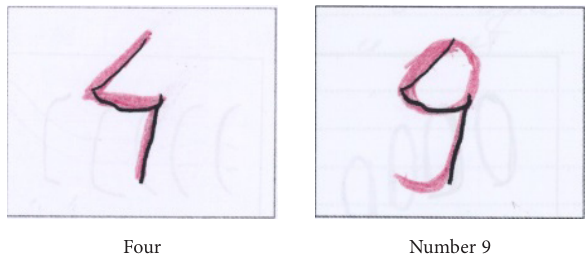
Figure 17. The creative task: interpretation of Fragment 3 – numbers (source: testingmom.com, 2020) One third (33.0%) of the research participants associated the presented fragment with a human: a face, a body and a nose. The number of links of the discussed fragment with a human halved, i.e. equalled 16.5 % in the process of interpretation (Figure 18).